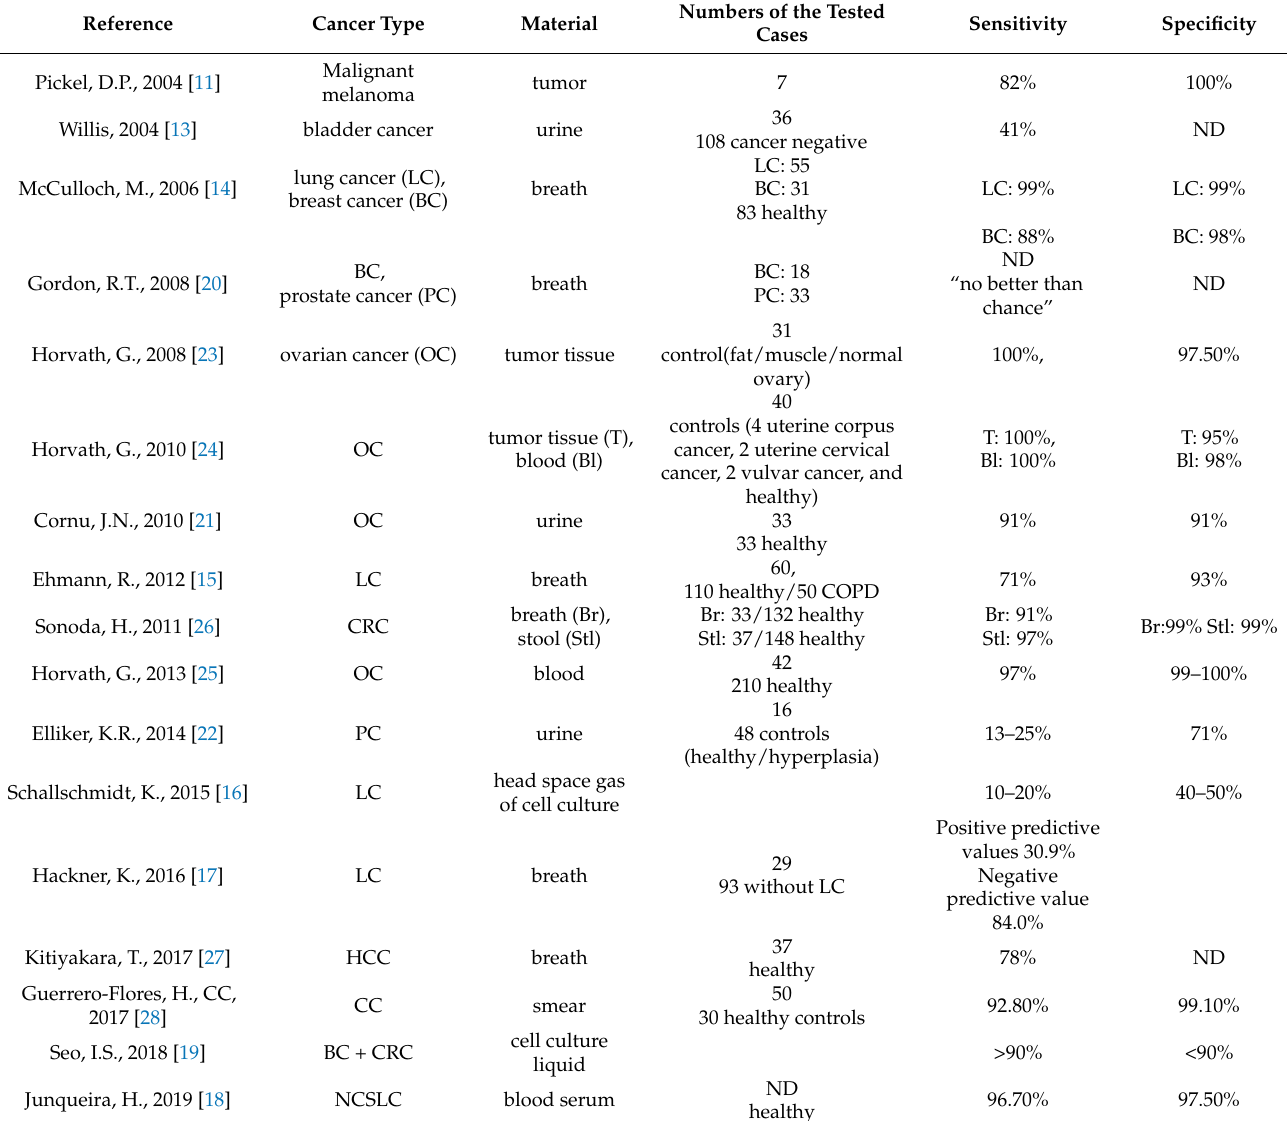
Table 3. Published reports on canine detection of various cancer